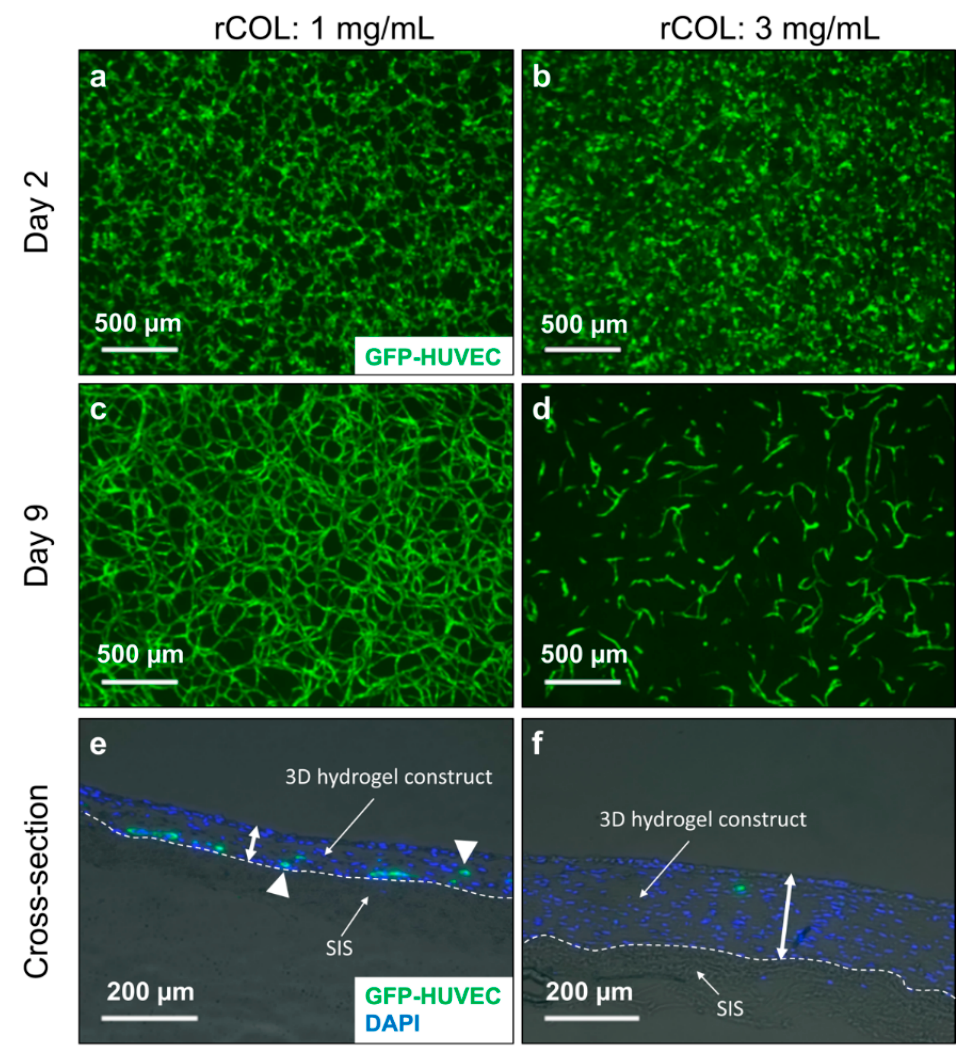
Figure 1. Assessment of GFP-HUVEC self-assembly into a network when co-cultured with unlabeled hASCs in 3D hydrogels of different rCOL concentrations. ( a , c ) Top view of 3D construct showing GFP- HUVEC in a hydrogel containing Matrigel TM and 1 mg / mL rCOL after 2 and 9 days in culture, respectively. ( b , d ) Top view of 3D construct showing GFP-labeled human umbilical vein endothelial cells (HUVEC) in a hydrogel containing Matrigel TM and 3 mg / mL rCOL after 2 and 9 days in culture, respectively. ( e , f ) 4’,6-diamidino-2-phenylindole (DAPI) staining of cross sections of GFP-HUVEC / hASC constructs containing Matrigel TM and 1 mg / mL or 3 mg / mL rCOL, respectively. White double arrows depict the height of the 3D hydrogel construct, the dashed lines depict the border between SIS and 3D hydrogel construct, and white triangles exemplary depict GFP-HUVECs. Scale bar: ( a – d ): 500 µ m, ( e , f ): 200 µ m.